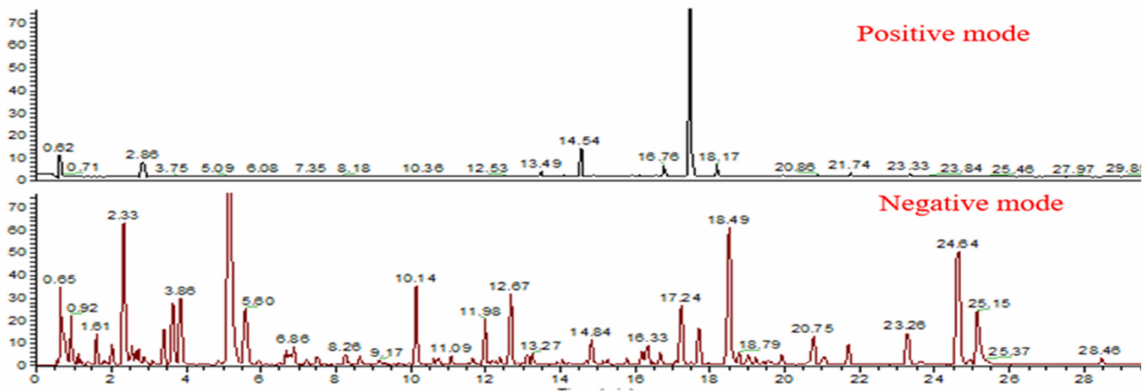
Figure 2. The typical BPI of GRR in positive and negative ion